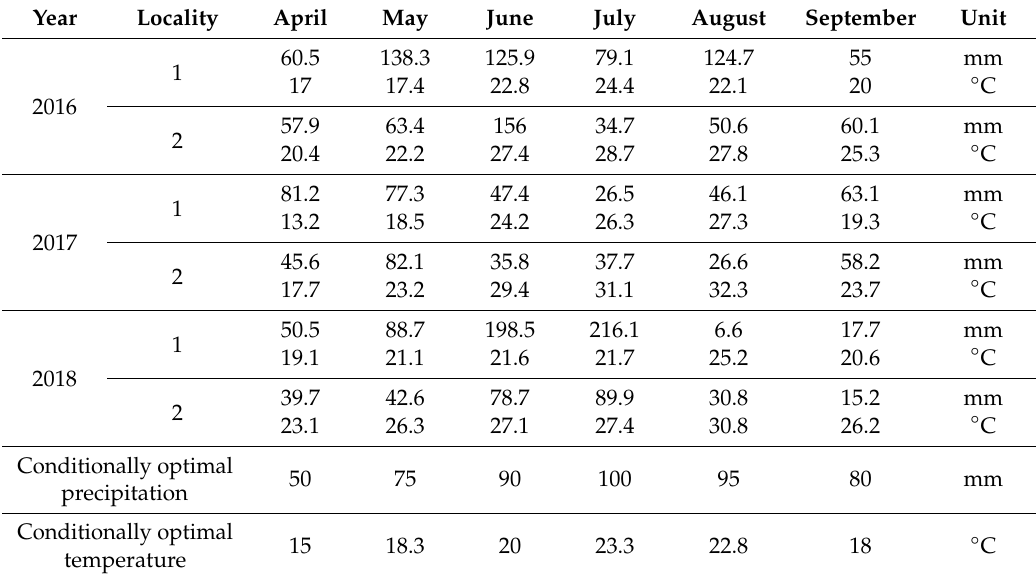
Table 5. Mean monthly air temperatures, precipitation amounts at sites 1 and 2, conditionally optimal average temperature values and conditionally optimal precipitation